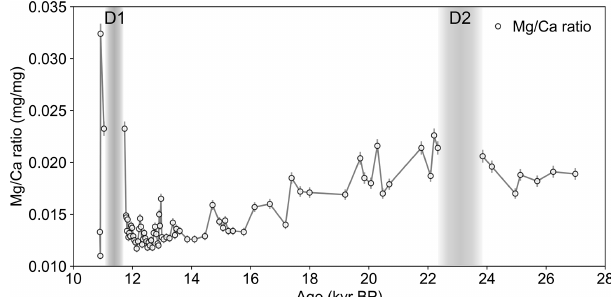
Figure 5. Mg / Ca ratio of stalagmite carbonate vs. modeled age. Error bars reflect the data reproducibility (overall 3% of measured values). Growth discontinuities D1 and D2 are highlighted by gray bars. The data show a general decreasing trend from the LGM to- wards Termination I, which is interrupted by highly increased val- ues around D1 at approximately 11.7kyrBP. Both hiatuses inferred from U-series dating are shaded in